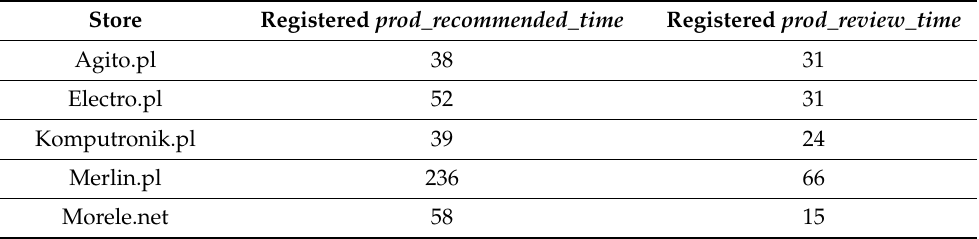
Table 3. Comparison of registered positive mouse activity between recommending interfaces and product review